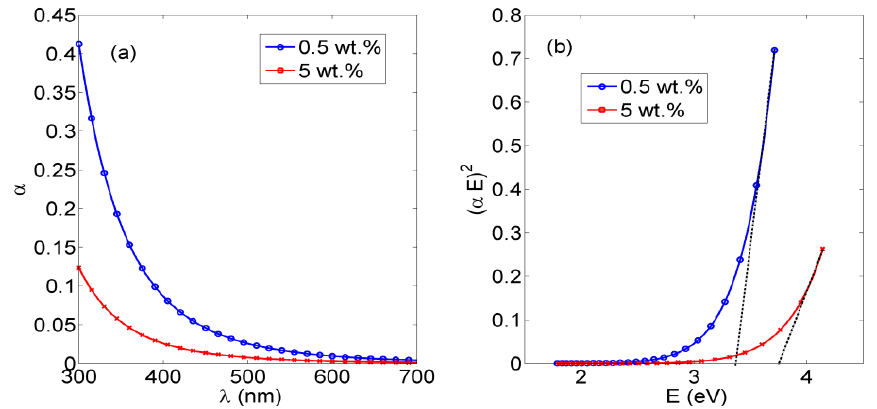
Figure 4. ( a ) The absorbance dispersion of crosslinked PVA NFs with in situ embedded different concentrations of ceria NPs, and ( b ) the corresponding direct allowed bandgap.